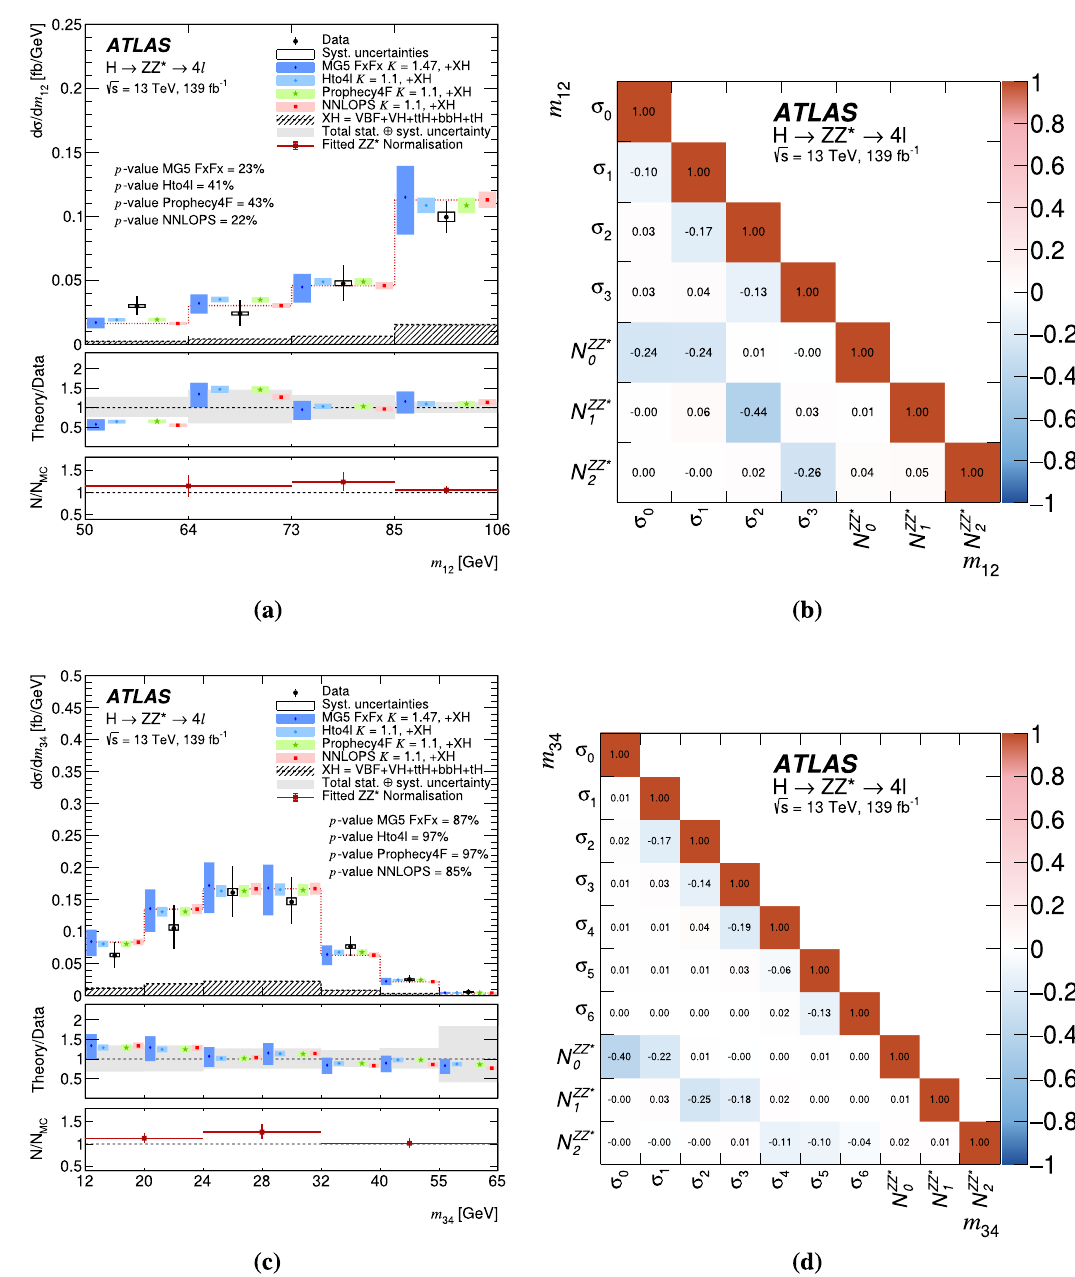
Fig. 20 Differential fiducial cross sections for a the invariant mass m 12 of the leading Z boson and c the invariant mass m 34 of the subleading Z boson, along with the corresponding correlation matrices between the measured cross sections and the Z Z ∗ background normalisation factors ( b and d